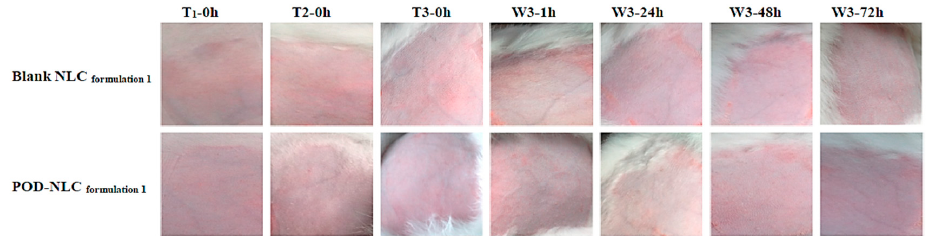
Figure 6. Images of intact rabbit skin before and after three times of topical administration of POD ‐ NLC formulation 1 or blank NLC formulation 1 . Notes: T 1 ‐ 0 h, T 2 ‐ 0 h and T 3 ‐ 0 h represent immediately before